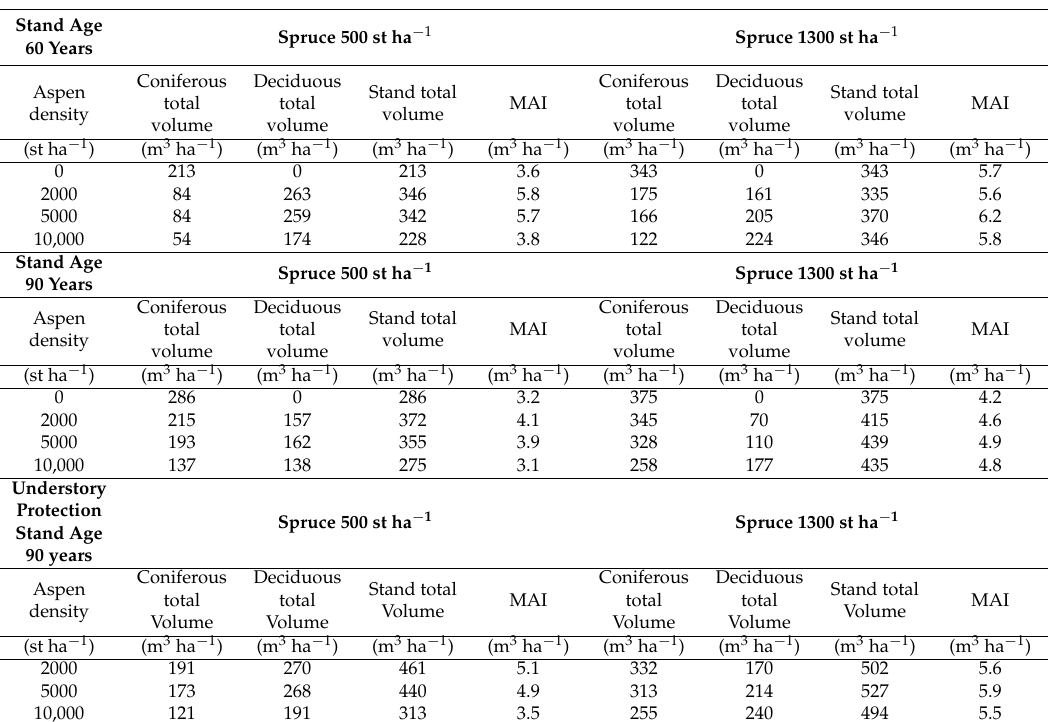
Table 5. Summary of MGM projections for 60 and 90 year rotations using a single entry harvest and a 90 year rotation with understory protection harvest for the Siphon Creek experimental plots. Understory protection volumes are the sums of harvest volume at age 60 plus volume harvested at age